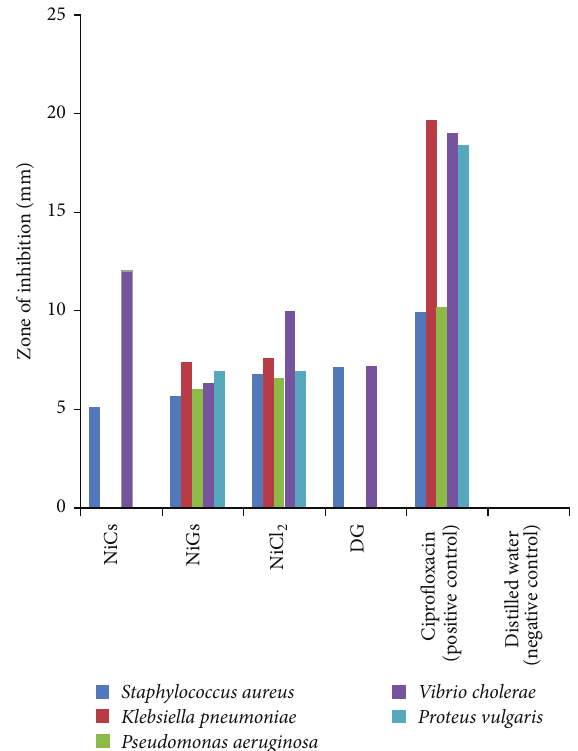
Figure 4: Comparison of antibacterial activities of NiGs, NiCs, NiCl 2 , DG, positive control, and negative control.